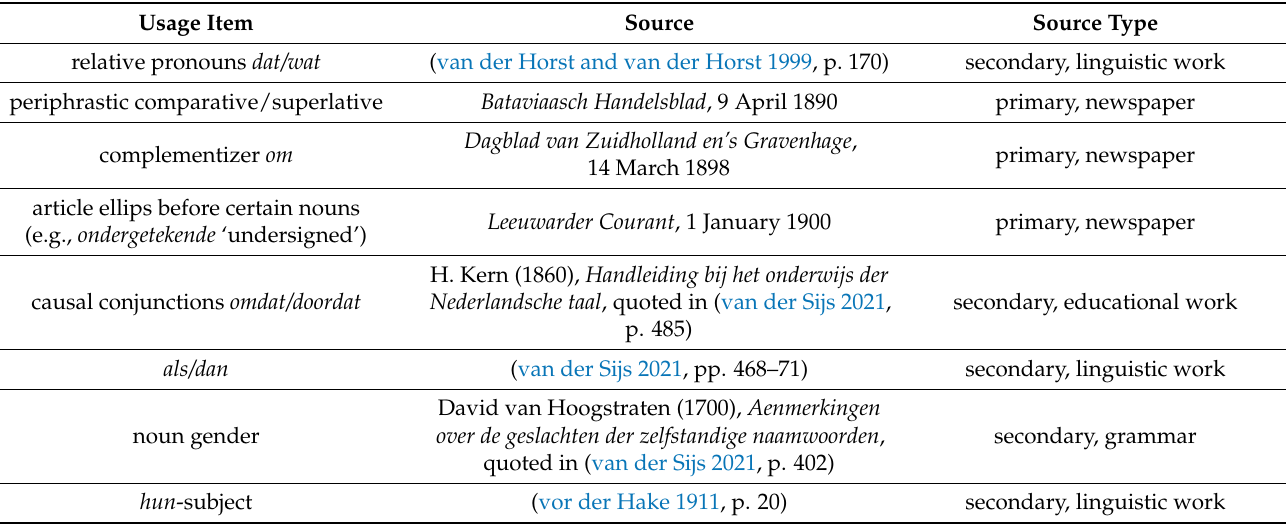
Table A2. Grammatical usage items with source used for evaluation against Recency Illusion and type of